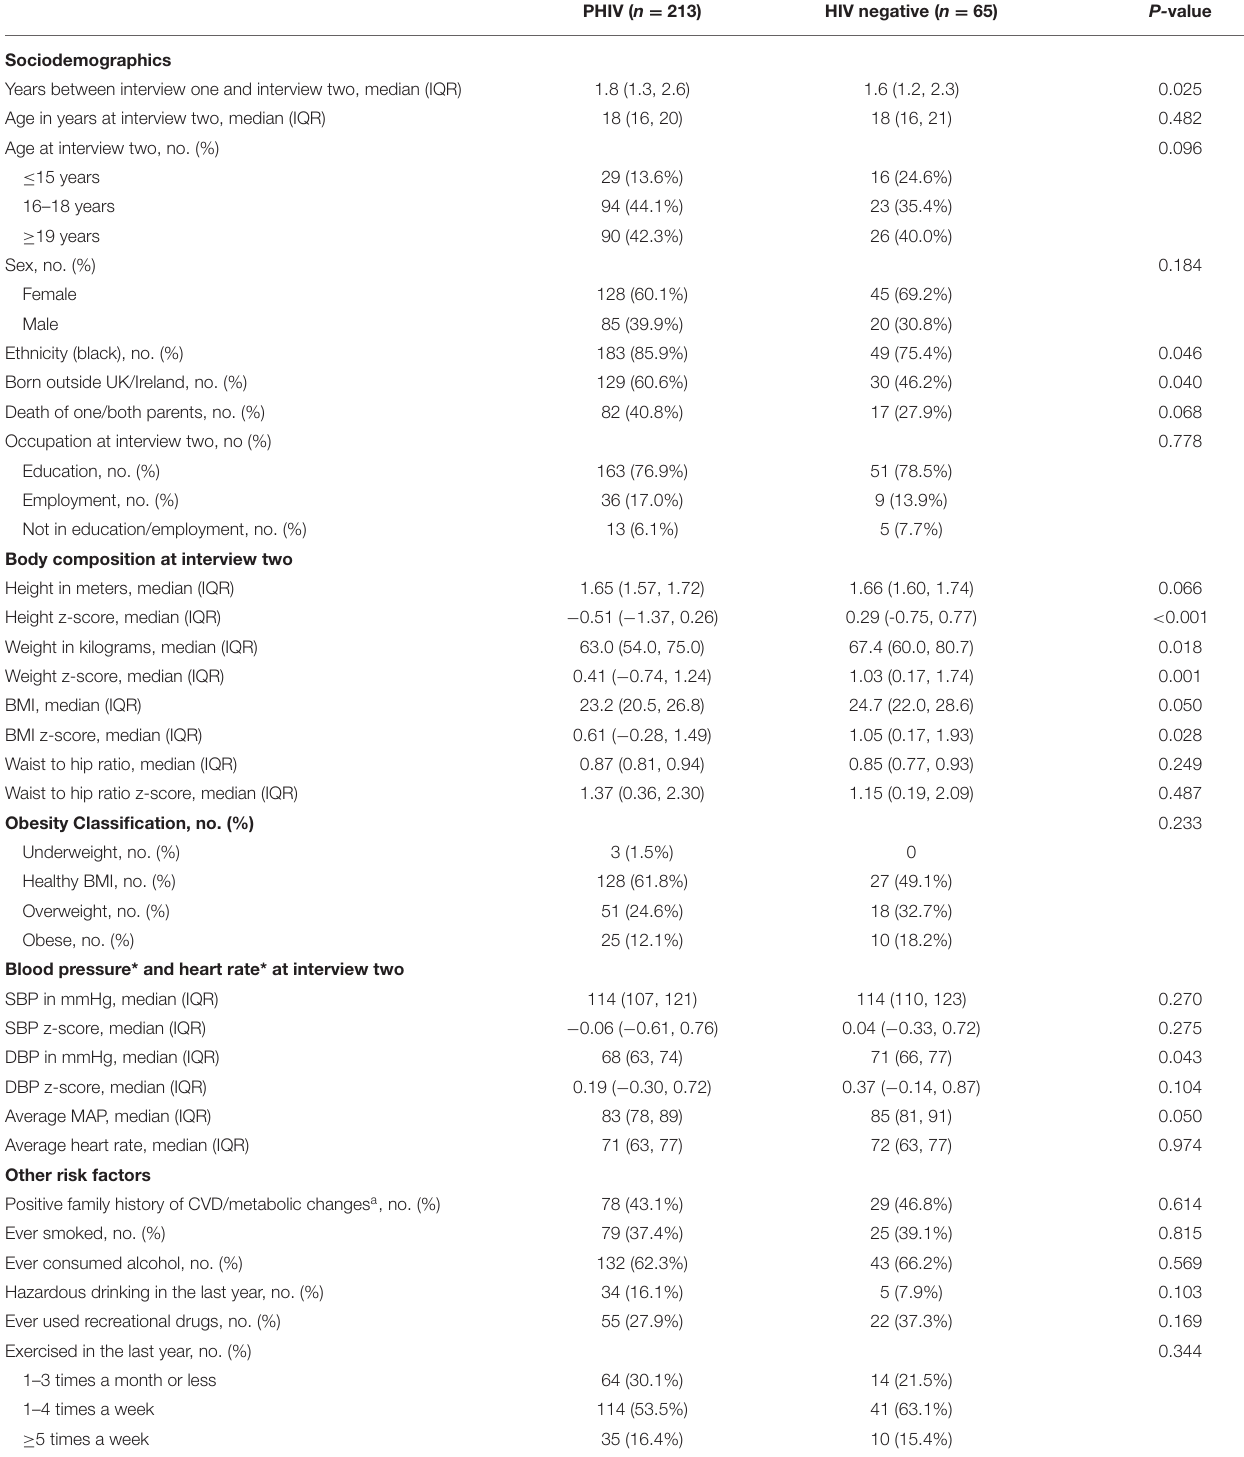
PHIV ( n = 213) HIV negative ( n = 65) P-